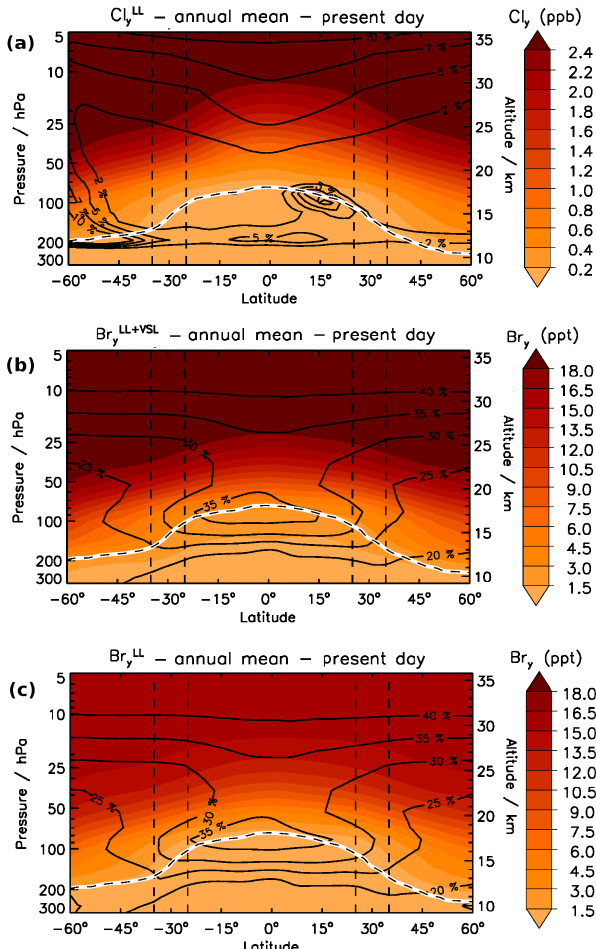
Figure 2. Annual zonal mean distribution of (a) Cl LL y , (b) Br LL + VSL y , and (c) Br LL y during the present-day period. The colour scale represents volume mixing ratios (ppb or ppt), while black contour lines show the contribution percentage of ClO x to Cl y and BrO x to Br y . The lower solid white line indicates the loca- tion of the tropopause (chemical definition of 150ppb ozone level from the experiment without VSL Br